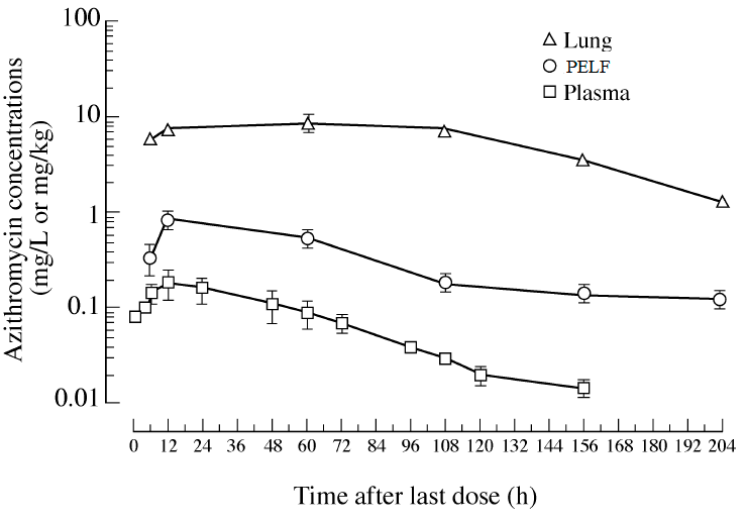
Figure 1. Concentrations vs. time semilogarithmic plot of azithromycin 500 mg per human patient once daily for 3 days in lung tissue, PELF and plasma. (Modified from Danesi et al. [39]). Copyright © 2003, Oxford University Press